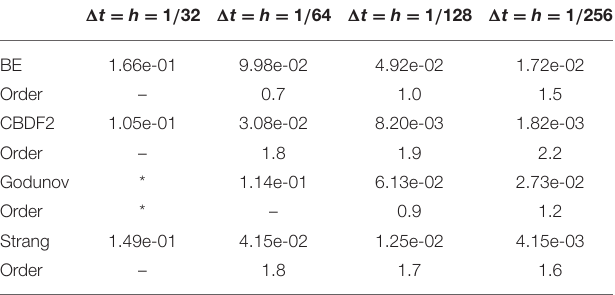
TABLE 1 | Errors of membrane potentials in the scaled discrete l 2 -norm of four different time integration methods.